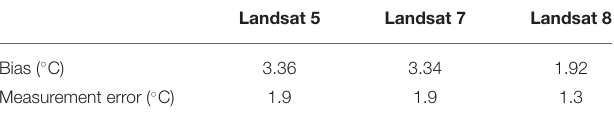
TABLE 1 | Calibration terms for Landsat satellites: The bias term represents the mean difference between satellite and buoy surface temperature and the error term represents one standard deviation of this